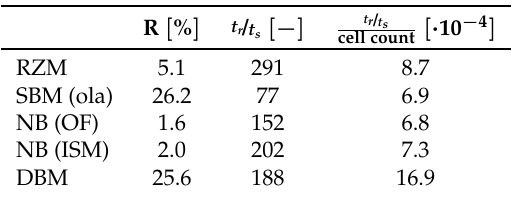
Table 15. Reflection coefficient, normalised run time and normalised run time per cell for the deep water